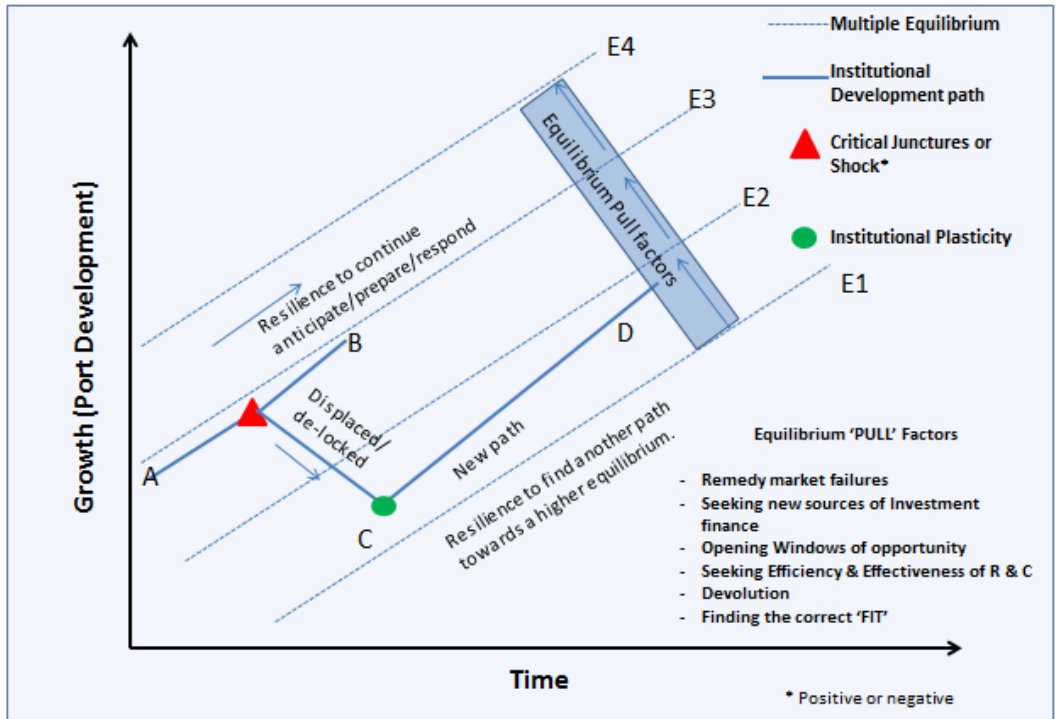
Figure 1. Institutional Development Path Trend (own elaboration based on literature review) At this lower equilibrium development position, the port authority (depending on the level of resilience) will once again seek a higher institutional equilibrium for its development. If an institutional change such as devolution for example cannot be achieved due to structural